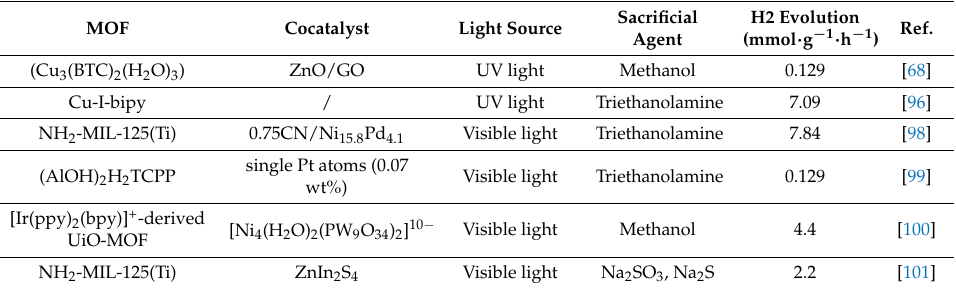
Table 3. A summary of MOFs mentioned in this review for water